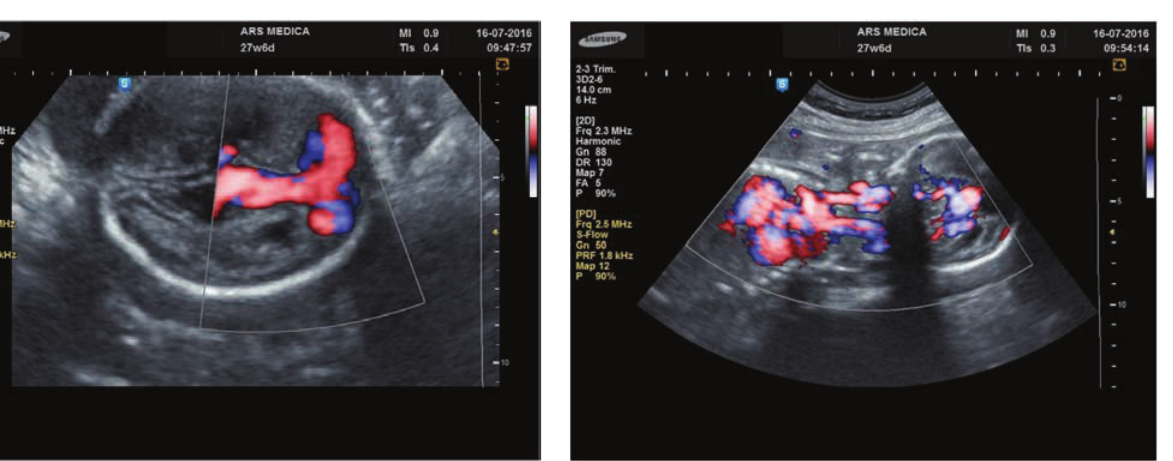
Figure 3: Fetal longitudinal parasagittal view: showing cardiomegaly and dilatation of aortic arch branches – brachiocephalic trunk and left common carotid